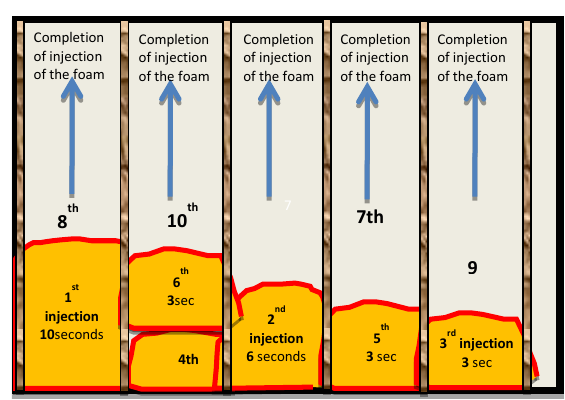
Figure 11. Quality check of the foam